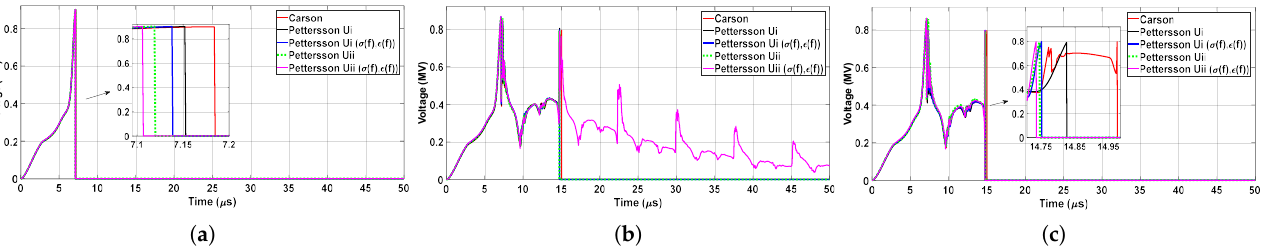
Figure 16. Overvoltage waveforms in phases A ( a ), B ( b ) and C ( c ), with or without a disruption process (backflashover), considering ground resistivity equal to 3000 Ω .m and a lightning stroke current waveform with α = 1.66.